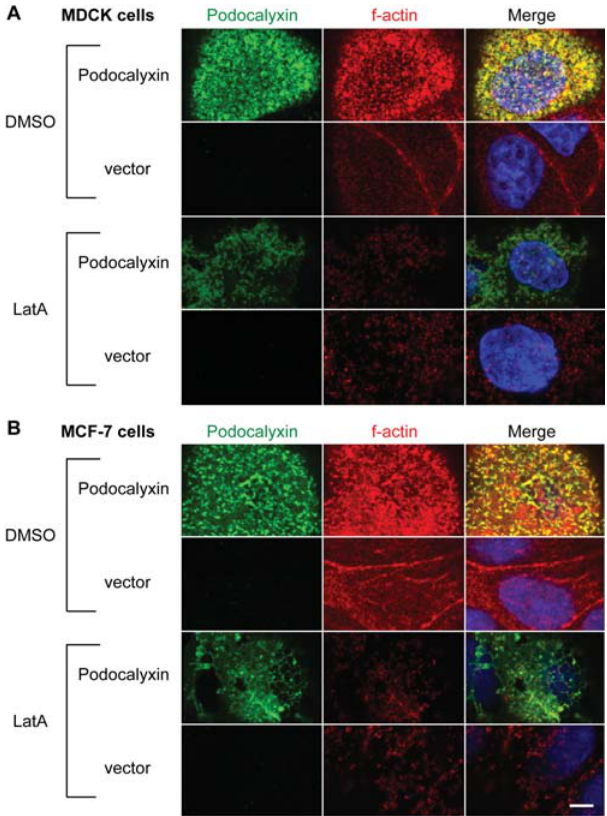
Figure 2. Podocalyxin-induced microvilli are structurally dependent on intact actin filaments. MDCK (A) and MCF-7 (B) cells transfected with murine Podocalyxin or empty vector were treated with the actin disrupting agent latrunculin A (LatA) or DMSO (negative control) and then fixed. Podocalyxin was labeled with an anti-Podocalyxin antibody (green); f-actin was labeled with phalloidin (red), and nuclei were labeled with DAPI (blue). Scale bar: 5 m m.